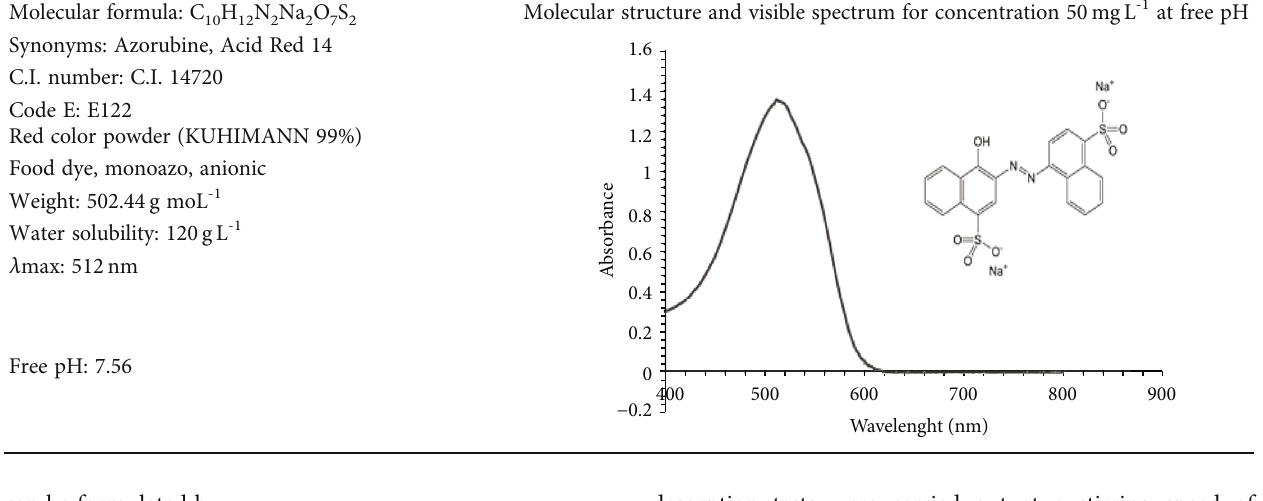
Table 1: Some characteristics of carmoisine